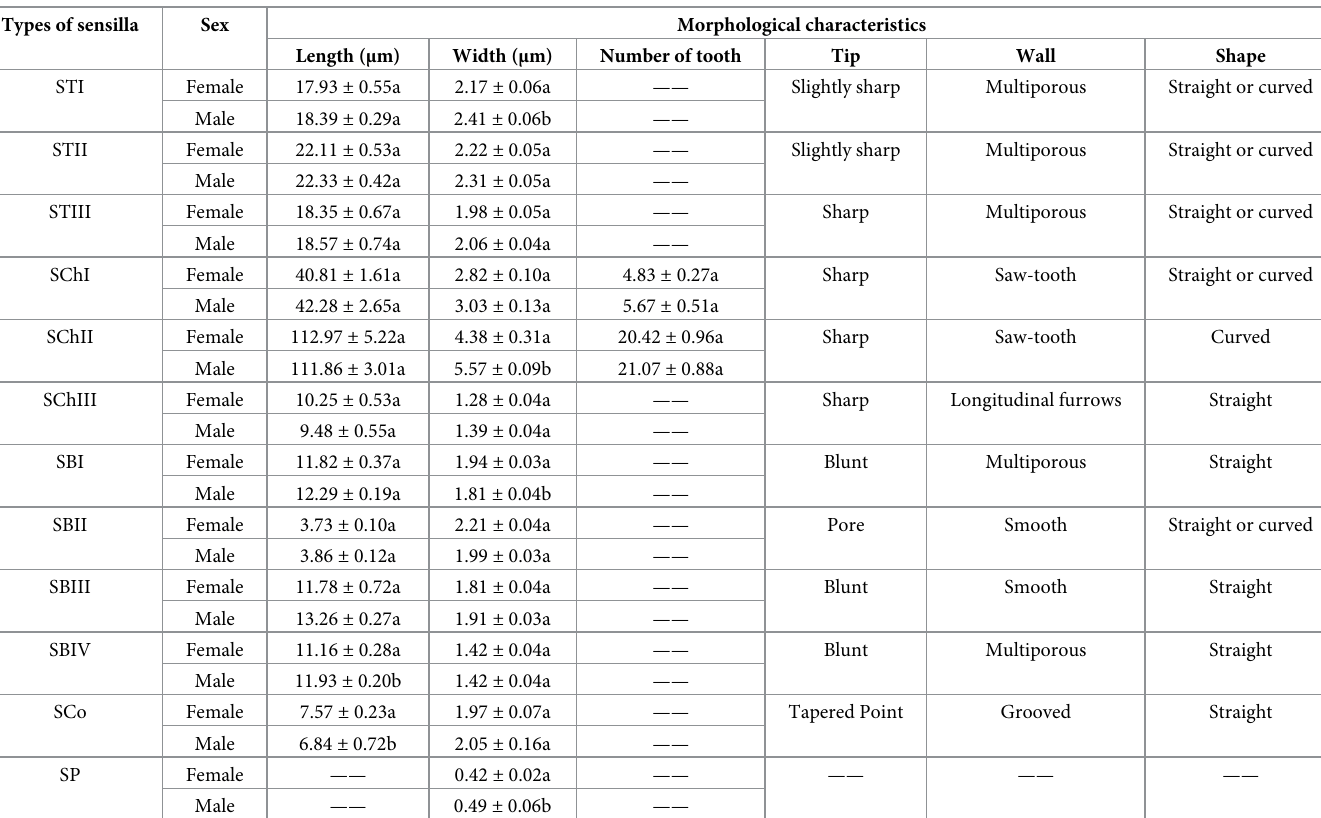
Table 2. Morphological characteristics of sensilla present in female and male E . parallelus (n = 12). Types of sensilla